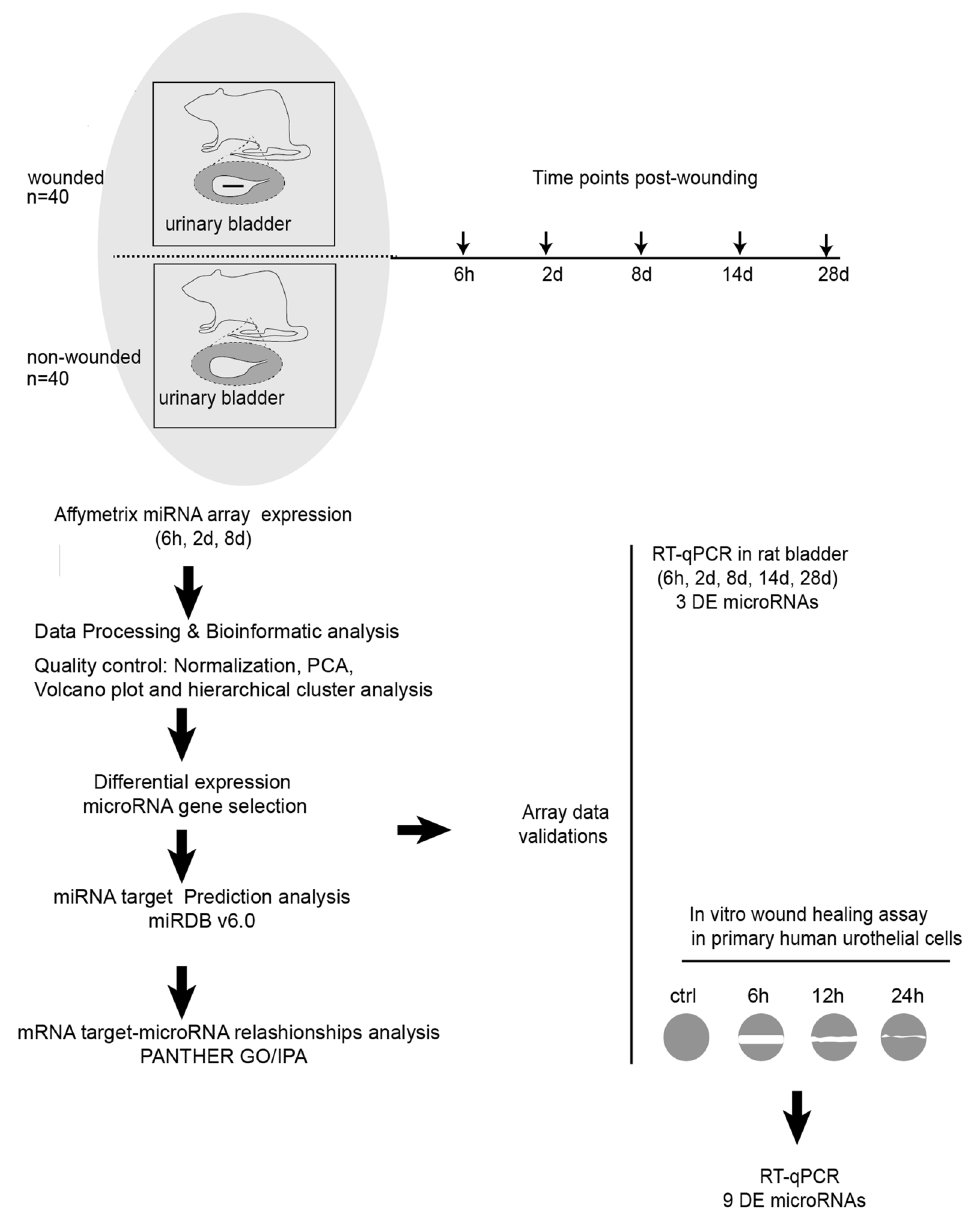
1. Cartoon describing the algorithm of the experimental design. A set of male rats received one- centimeter-long longitudinal incisions through all the layers of the urinary bladder wall. The bladder tissue was harvested at 6 h, 2 days, 8 days, 14 days and 28 days post-injury. A parallel set of sham operated rats were used as a control. DE microRNA genes were captured with Affymetrix array using samples form 0 h, 6 h, 2 days and 8 days post injury. Samples from all the time points were included for real time PCR validations in the rat bladder tissues. Relevance of the results was also validated in in vitro wound healing assays in human primary urothelial cells. The predicted target genes associated to the DE microRNAs and the associated biological functions associated were obtained through bioinformatic